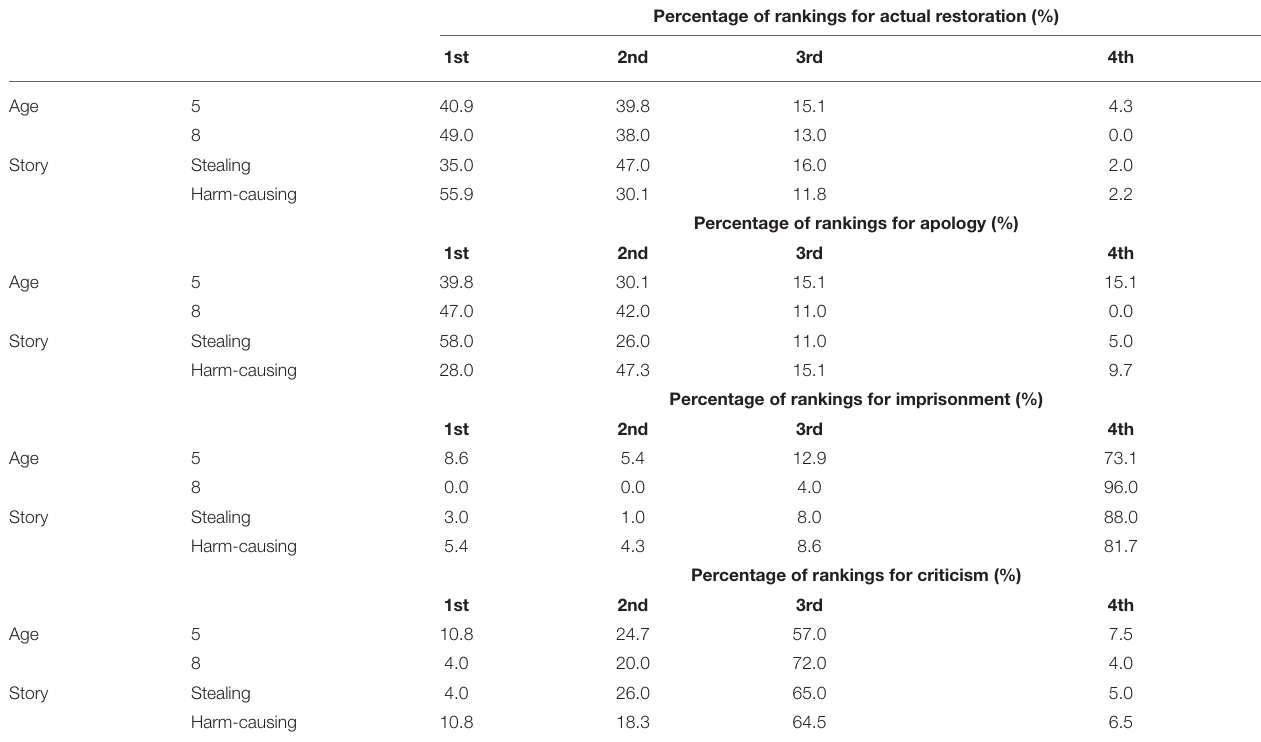
TABLE 1 | Percentage of each ranking (1st-4th) for the four treatments.